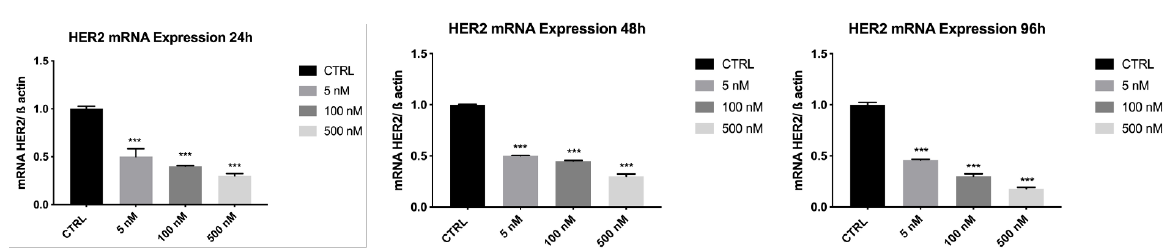
Figure 8. Effect of Z HER2:2891 DCS-MMAE on HER2 expression in SK-BR-3 cells. Cells were treated for 24, 48, and 96 h. The p -value was determined by one-way ANOVA test with Dunnett post hoc test and considered significant for p < 0.001 *** compared to control. Data are presented as mean ± SEM.